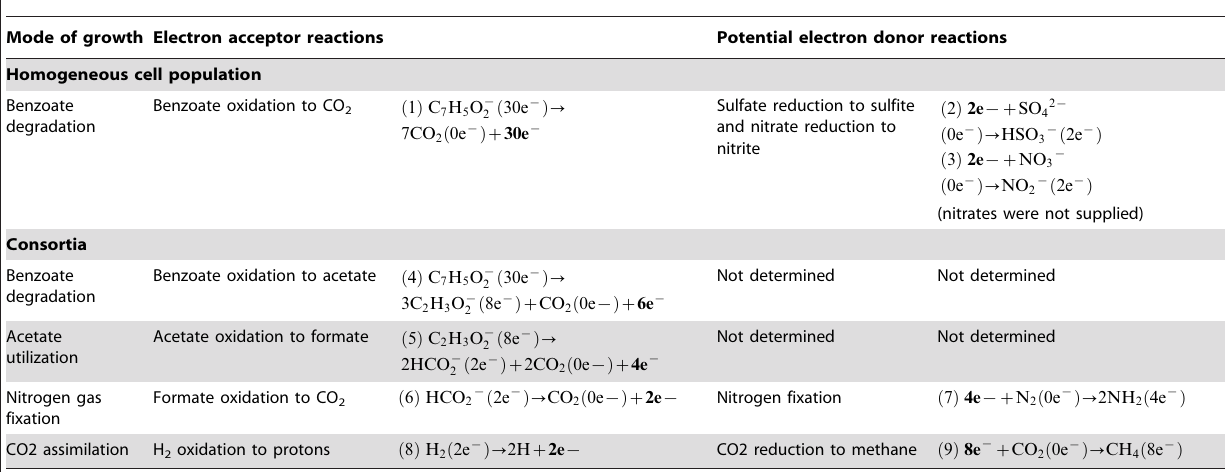
Table 1. Basic components of the putative electron donor and electron acceptor reactions under different modes of the R. palustris growth (the reactions are written according to Zwolinski et al. [3]